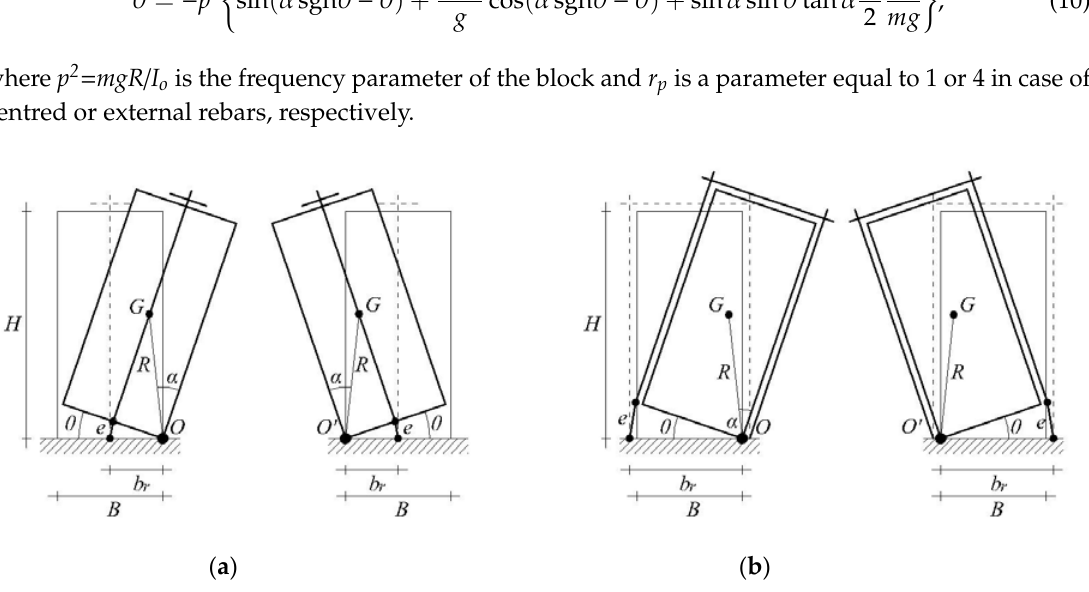
Figure 5. Model geometry of the block retrofitted with centred ( a ) or external ( b ) vertical rebars.